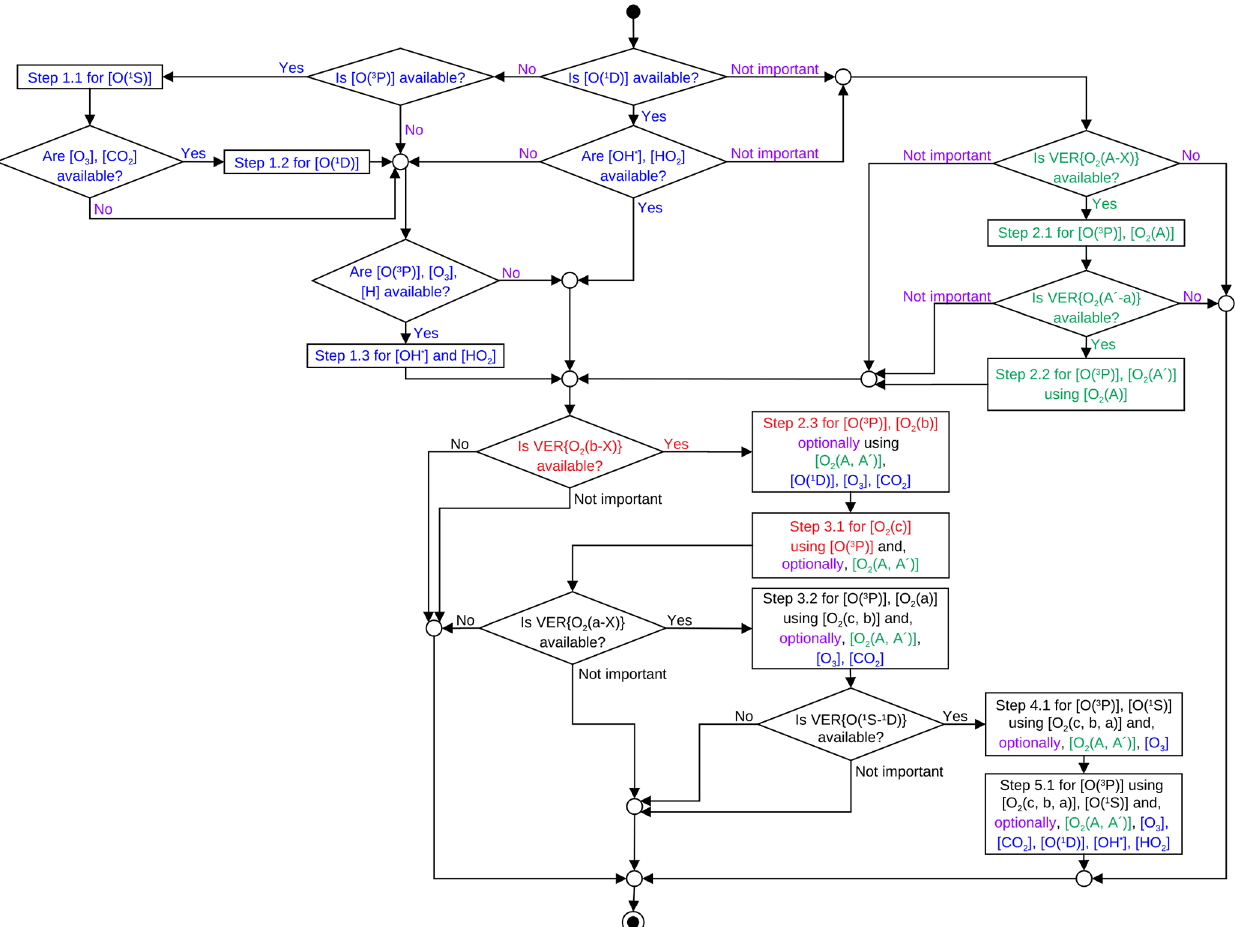
Figure A1. The flowchart shows retrieval steps resulting in [ O ( 3 P) ] and carried out according to the proposed MAC approach. The start and end states are denoted by filled black circles on the top and bottom of the figure, respectively. Decisions and processes are denoted by rhombs and rectangles, respectively. Connectors are denoted by empty circles. The flowchart is read following lines with arrows from one flowchart symbol to another. The prior retrieval procedure is described by the text shown in blue. If the prior retrieval procedure can be omitted (as is the case for the ETON campaign), then the corresponding decision “not important” (shown in violet) near a rhomb is to be taken, which is denoted by “optionally” (shown in violet in a rectangle) and is relevant for the optional calculation result (shown in blue in a rectangle). The optional procedure carried out to calculate [ O 2 (A) ] and [ O 2 (A (cid:48) ) ] is described by the text shown in green. If emissions in the Herzberg I and Chamberlain bands are not available (see “no” shown in violet near the respective rhombs) or optional (see “not important” shown in violet near the respective rhombs), then this optional procedure can be omitted at steps 2.3 and 3.1; see [ O 2 (A) ] and [ O 2 (A (cid:48) ) ] shown in green in the respective rectangles. Note that the [ O ( 3 P) ] retrieval can be carried out most accurately if values of VER { O 2 (b − X) } are available, which is indicated by the text shown in